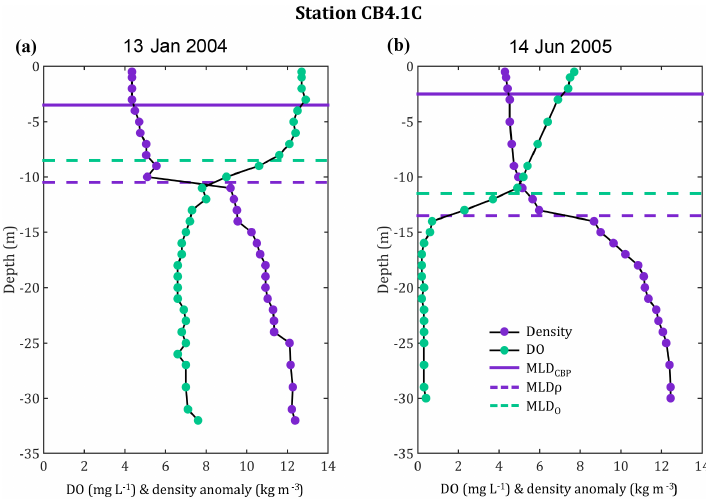
Figure 3. Density and dissolved oxygen profiles for a mid-bay station (CB4.1C) on (a) 13 January 2004 and (b) 14 June 2005, comparing the 0.1kgm − 4 stratification definition used by the CBP (MLD CBP ) with the 10% threshold definitions used here for density (MLD ρ ) and oxygen (MLD O